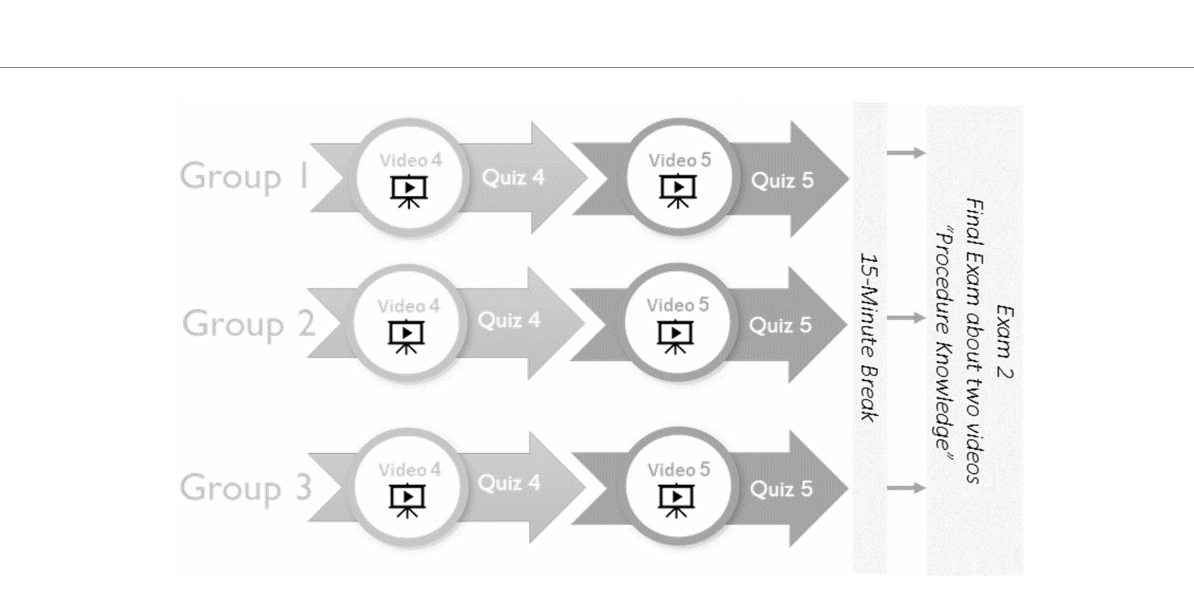
FIGURE 4 Procedure for experimental phase 2: Procedural